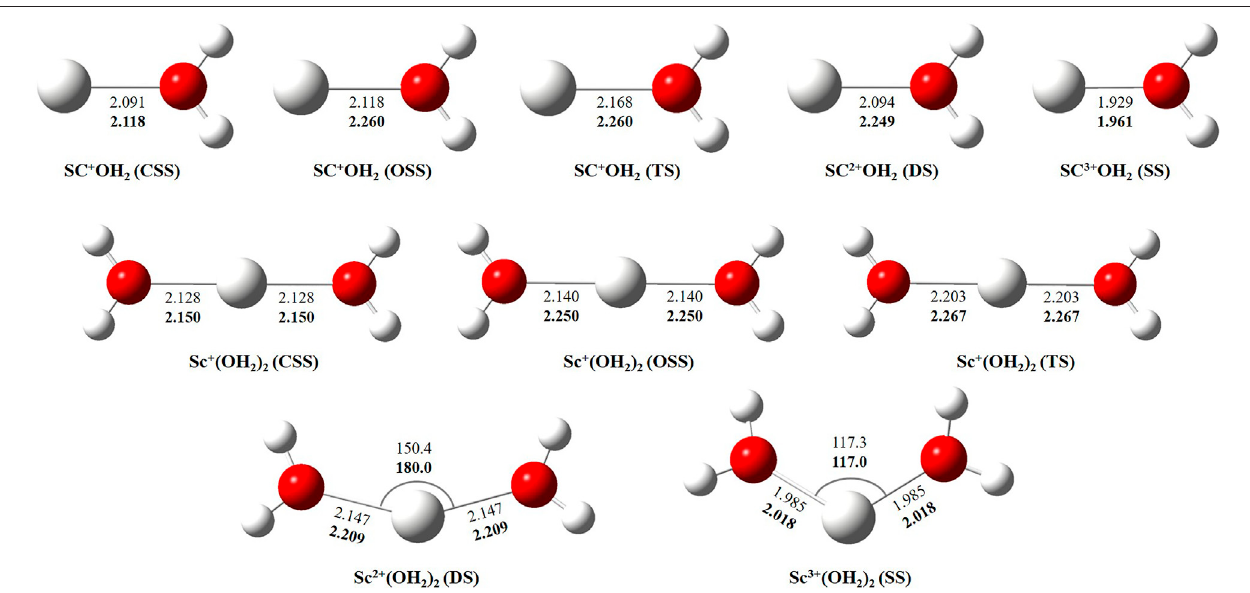
FIGURE 2 | Geometrical parameters of the close-shell singlet (CSS), open-shell singlet (OSS), and triplet-state (TS) geometry of Sc + (OH 2 ) n , doublet-state (DS) geometry of Sc 2+ (OH 2 ) n , and singlet-state (SS) geometry of Sc 3+ (OH 2 ) n , where n (cid:2) 1-2, complexes obtained at B3LYP (normal) and MP2 (bold) using the 6-31G* basis set. Bond distances and angles are given in angstrom and degree,